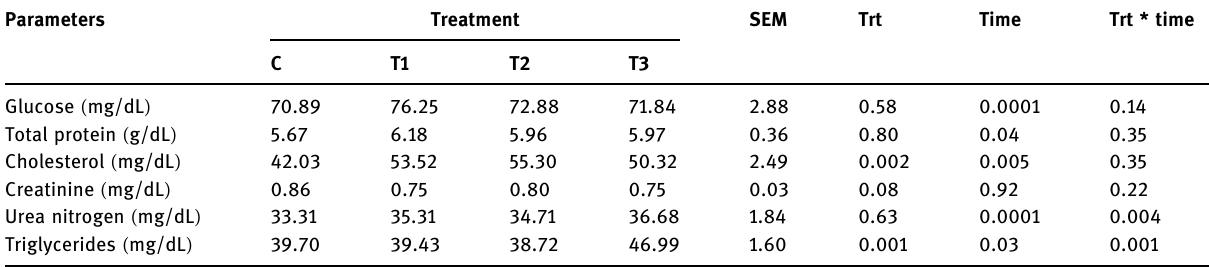
Table 4: E ff ect of DFM supplementation on Najdi newborn lambs, sampling time, and interaction with blood serum during the feeding trial